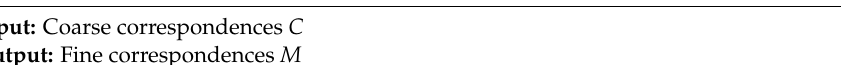
Algorithm 3. Correspondence